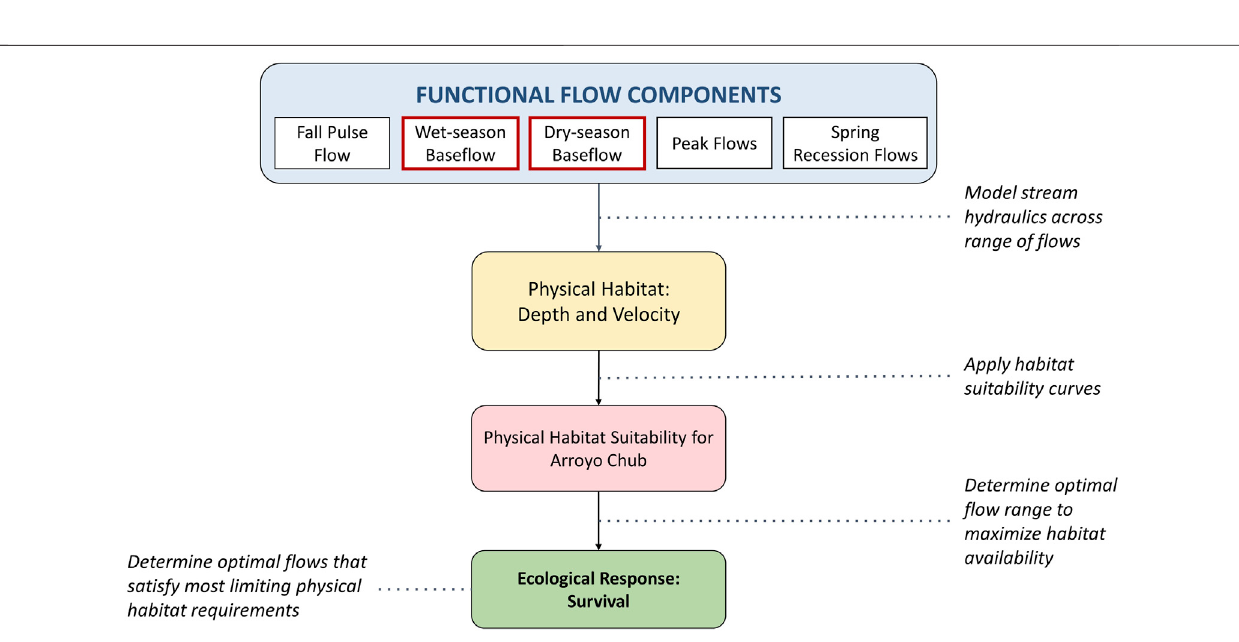
Frontiers in Environmental Science |